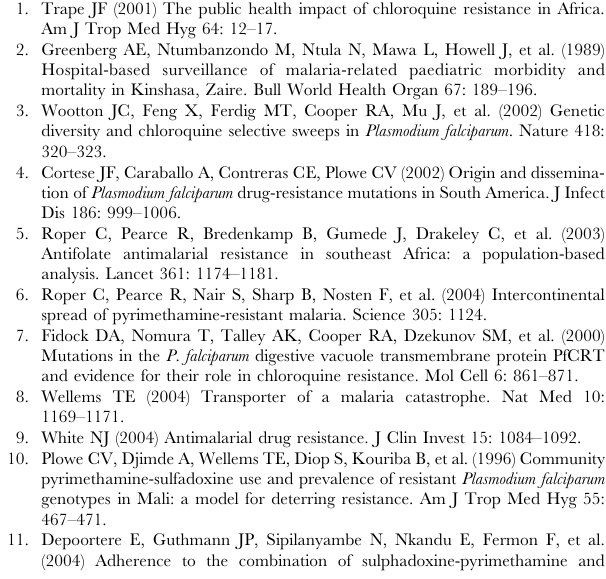
Table S3 Pfdhfr flanking microsatellite